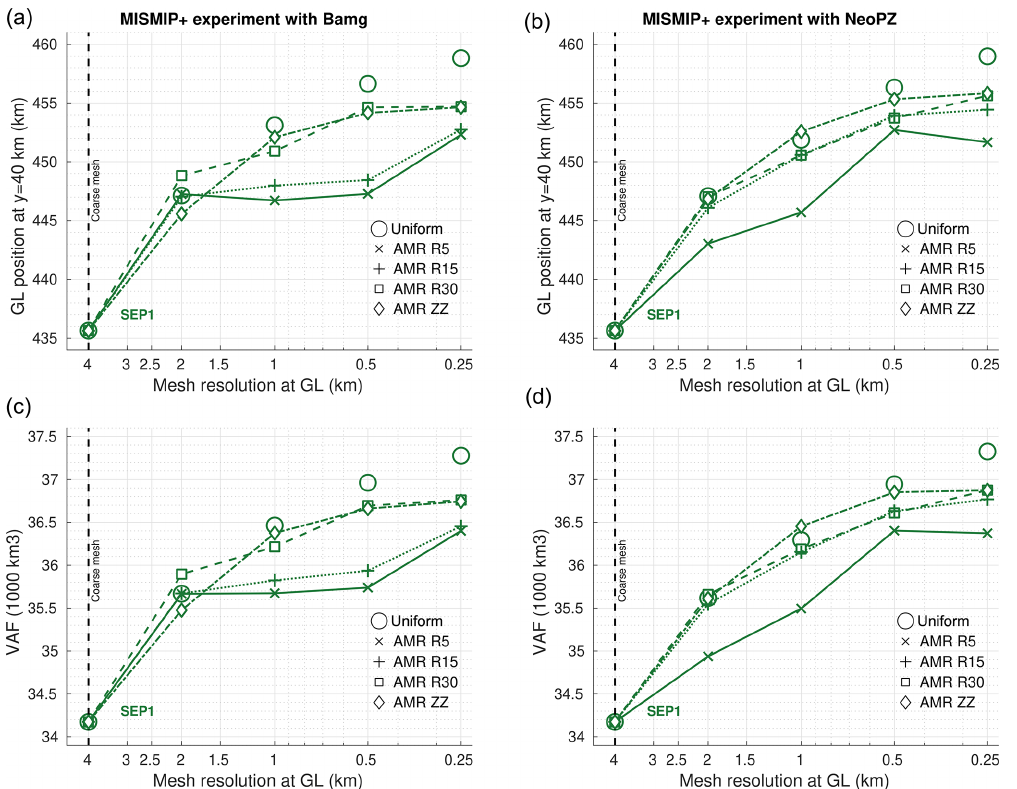
Figure 7. GL positions (a, b) and VAF (c, d) obtained from the coarse mesh and from AMR for four refinement criteria: R5, R15, R30 and ZZ (see Tables 1 and 2). Results from uniformly refined meshes (uniform) are also shown. The simulations are carried out through the mesh generators Bamg (a, c) and NeoPZ (b, d) using sub-element parameterization 1 (SEP1). The thresholds for element/group used in the ZZ criterion are, respectively, (cid:15) max τ,e = 0 . 08 (cid:15) max τ (for both Bamg and NeoPZ) and (cid:15) max τ,g = 0 . 04 (cid:15) max τ for NeoPZ and (cid:15) max τ,g = 0 . 008 (cid:15) max τ for Bamg, where (cid:15) max τ is the maximum error value observed in the coarse mesh.